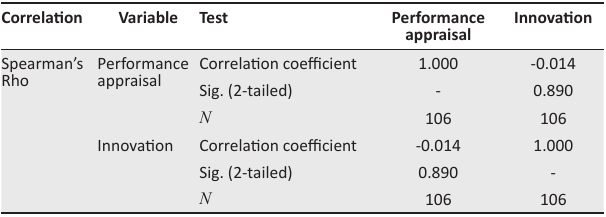
TABLE 4: Spearman’s correlation on performance appraisal versus innovation.